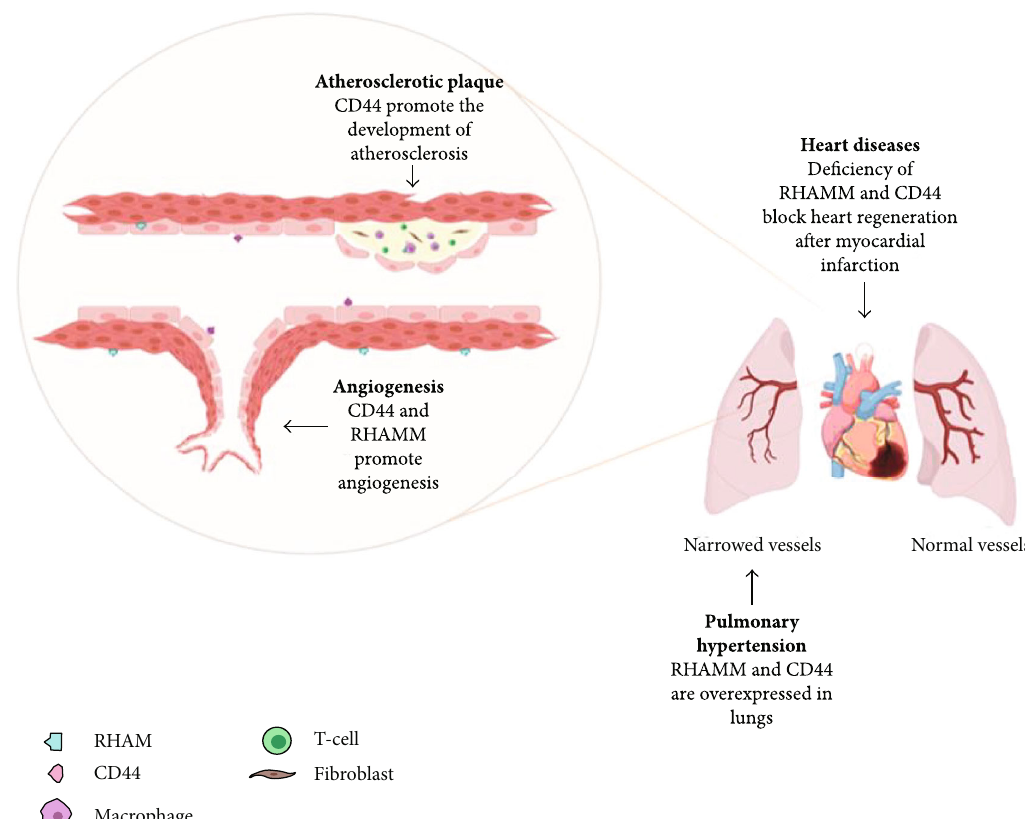
Figure 2: Diagram describing the role of RHAMM and CD44 receptors in the cardiovascular system. Created with